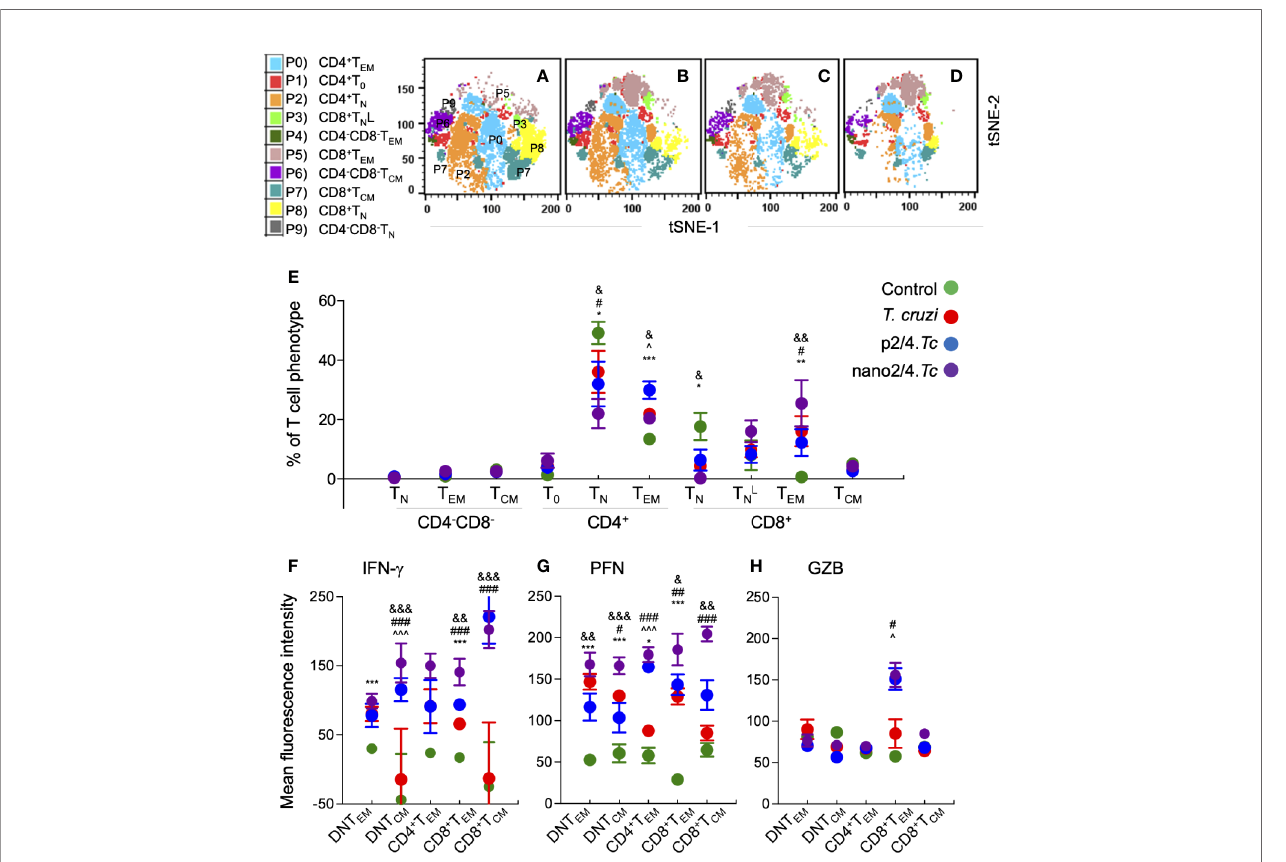
FIGURE 3 | Effect of nanovaccine on dynamics of T cell sub-populations in peak parasitemic phase. C57BL/6 mice were immunized, infected, and euthanized on day 21 pi corresponding to peak parasitemic phase. Single cell suspensions of splenocytes were labeled with fl uorescent-conjugated antibodies and analyzed by fl ow cytometry. FlowSOM analysis of CD3 + splenic T cells of mice ( n ≥ 5 per group) based on the expression levels of CD4, CD8, CD25, CD62L, and CD44 antigens generated self-organizing ten meta-clusters (referred as P0 – P9). (A – D) The tSNE (t-distributed stochastic neighbor embedding) plots were generated with non-linear reduction method to visualize all the 10 sub-populations in two-dimensional space in control (A) , infected (B) , p2/4. Tc (C) , and nano2/4. Tc (D) groups of mice. (E) Bar graph shows P0 – P9 sub-populations of T cells in the four groups of mice. (F-H) Median fl uorescent intensity was calculated for intracellular cytokine (IFN- g ) and markers of T cell cytotoxicity [perforin (PFN) and granzyme B (GZB)] in T central memory (T CM ) and T effector/effector memory (T EM ) subsets. All data are derived from n = 5 – 10 mice per group ( ≥ 2 observations per sample) and plotted as mean values ± SEM. Signi fi cance is presented as described in Figure 1 . Detailed data (mean values ± SEM and signi fi cance) are shown in Tables S2B and S3B